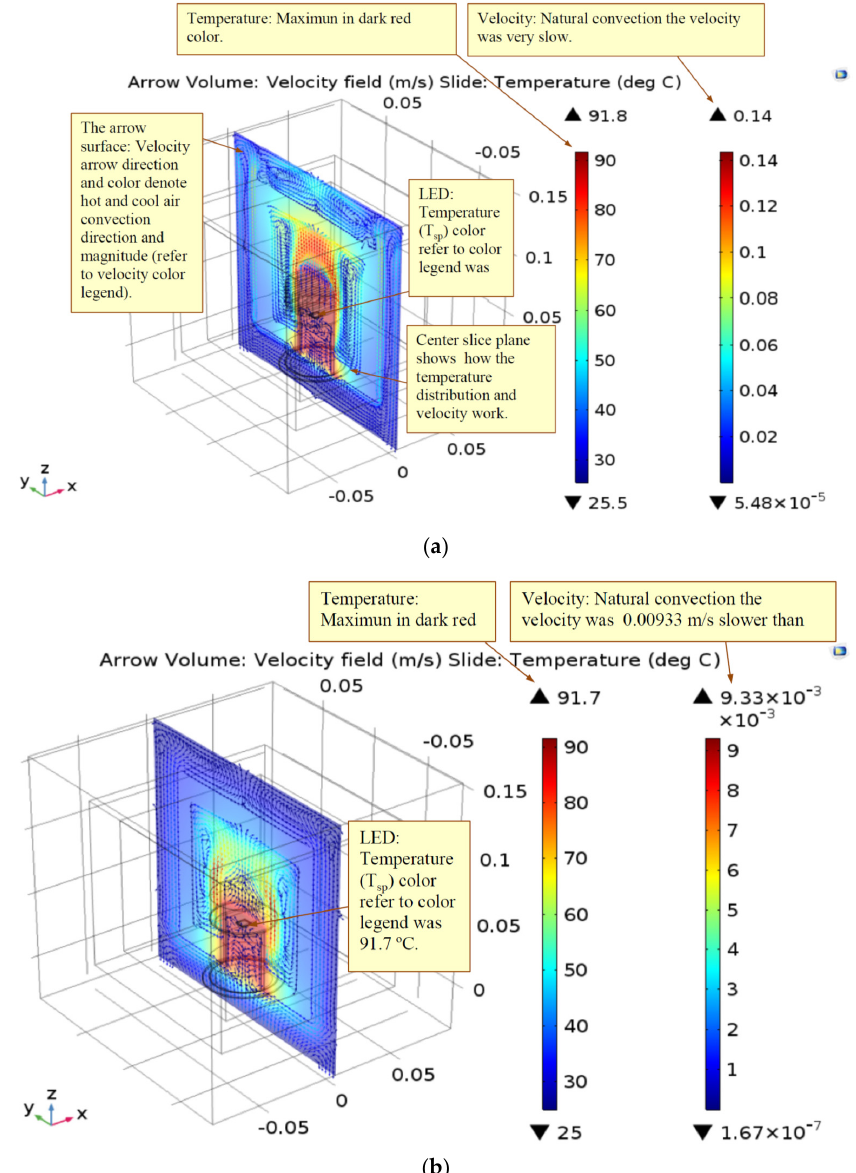
Figure 6. Illustration for the numerical simulation results of the CLRDL after INST ( a ) with mounted ALFHS, and ( b ) with mounted CUFHS. ALFHS; and ( b ) with mounted